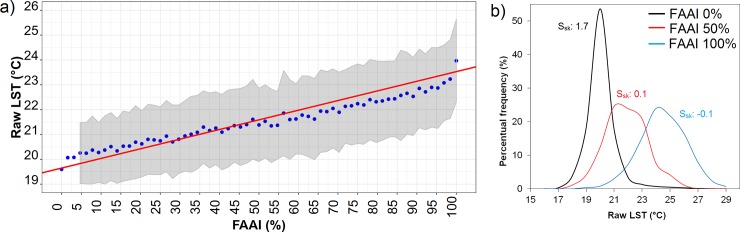
(a) Relationship of raw LST (°C) with FAAI (%) (blue circles are average LST at each FAAI class; grey shaded area is bounded by standard deviation of LST per FAAI class; red line is linear regression of all LST data against FAAI, LST = 0.03 FAAI + 19.6; R2 = 0.6, significant p-value < 2.2e-16); and (b) histogram of the LST distribution at each FAAI class 0%, 50% and 100% and associated skewness coefficient (Ssk).